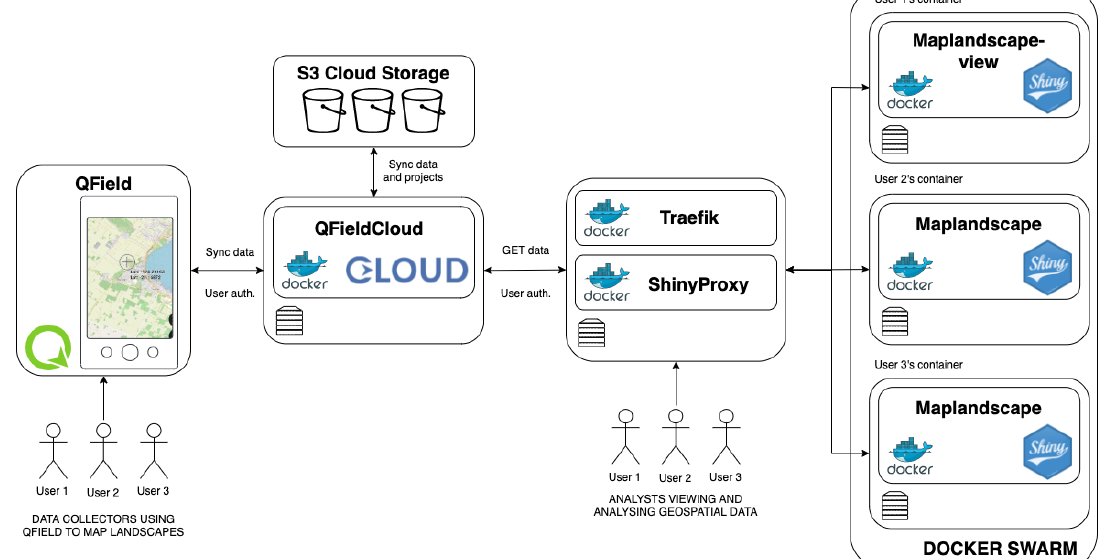
Figure 3. ICT system architecture and software components of the geospatial tool.